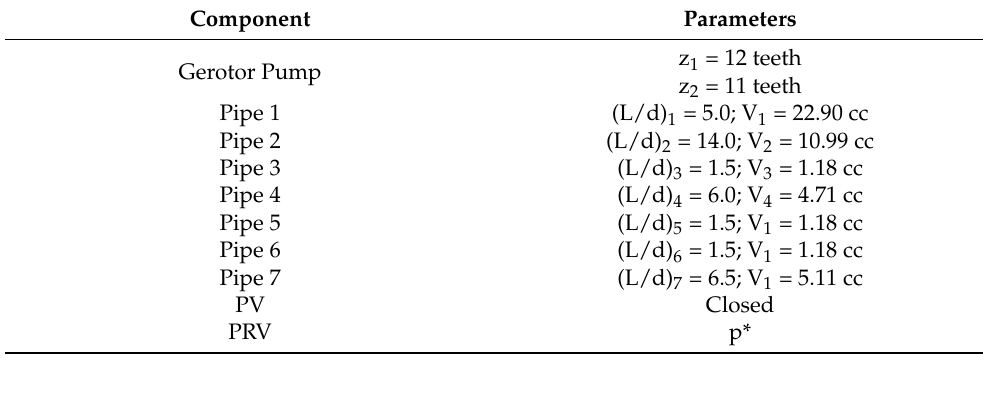
Table 1. Hydraulic circuit parameters.